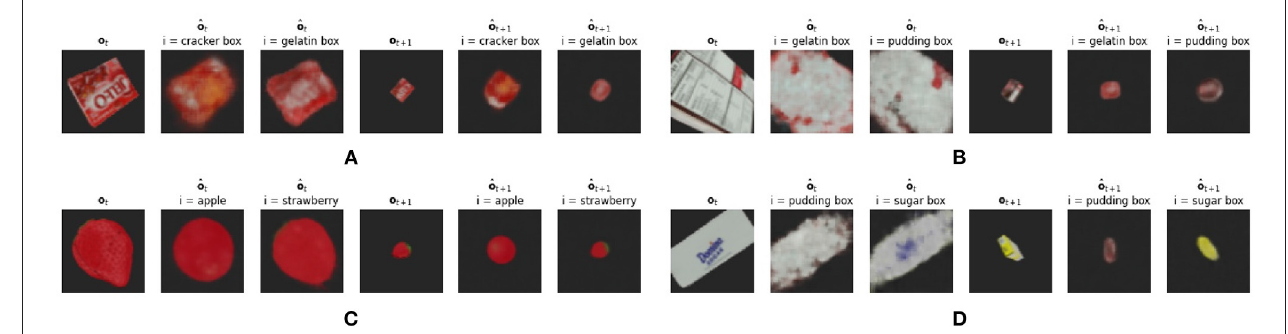
FIGURE 5 | Ambiguities found in the ensemble CCN classifier. From left to right: initial observation o t provided to the agent. The reconstruction ˆ o t predicted using the expected model. The reconstruction ˆ o t predicted using the correct model. The chosen next observation o t + 1 through the minimization of expected free energy G . The expected observation ˆ o t + 1 using the selected model. The expected observation ˆ o t + 1 using the correct CCN model. (A) The gelatin box. (B) The pudding box. (C) The strawberry. (D) The sugar